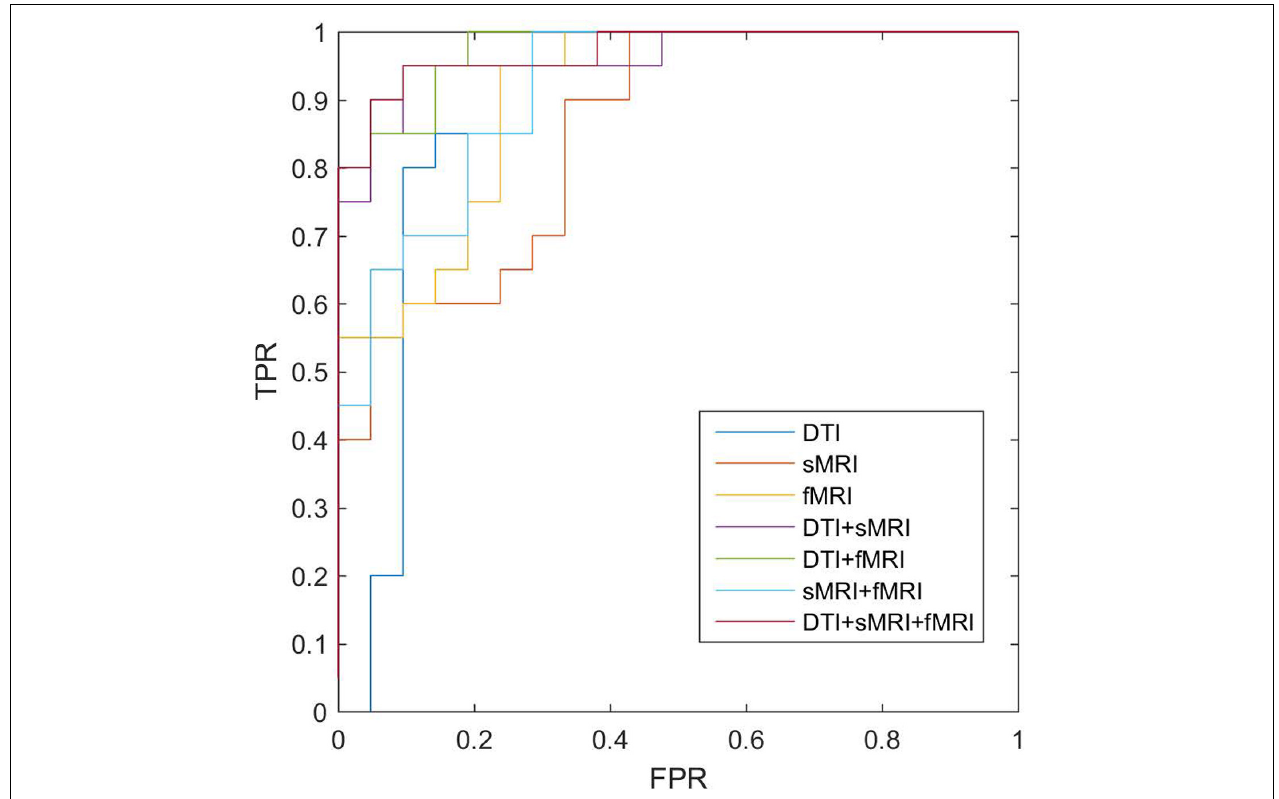
FIGURE 4 | ROC of classifications based on different modalities. sMRI, structural magnetic resonance imaging; DTI, diffusion tensor imaging; fMRI, functional magnetic resonance imaging; ROC, receiver operating characteristic.